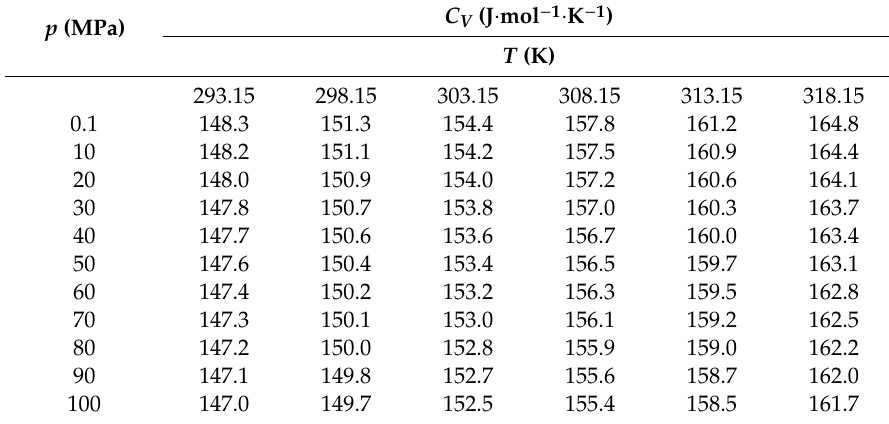
Table 10. The isochoric molar heat capacity, C V , of 1-butanol at pressures up to 100 MPa and within the temperature range from (293 K to 318) K.